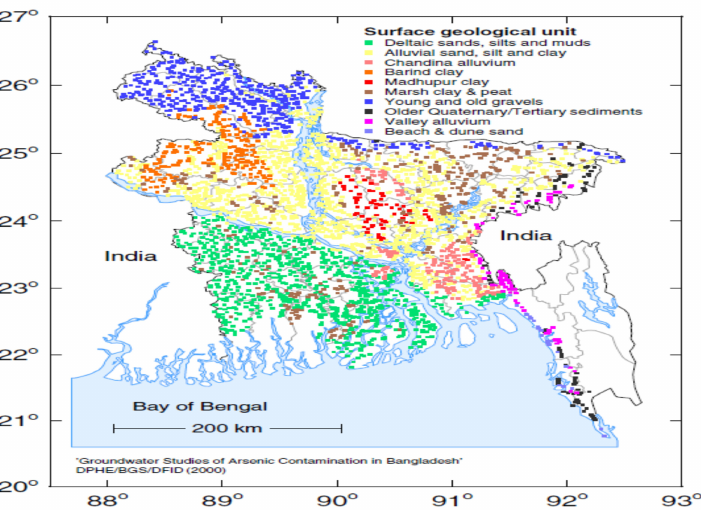
Figure 3. Surface geological units of Bangladesh [27]. Reproduced with permission from BGS.